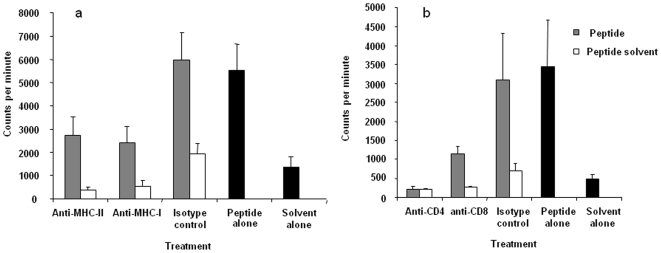
Determination of MHC restriction of response to H5246–260.Antibodies against MHC I and MHC II (A) and anti-CD4 and anti-CD8 (B) were used to block proliferative response to peptide, H5246–260. In at least 5 replicate experiments, spleen mononuclear cells from vaccinated birds were incubated with 5 µg/ml antibodies or isotype control before addition of peptide or solvent control. There were two additional groups of control cells, one being treated with the peptide without addition of any antibodies (peptide alone) and the second being treated with peptide solvent without addition of any antibodies (solvent alone). Proliferation was measured at 72 hours. Data are presented as counts per minute and error bars represent standard errors of the mean.